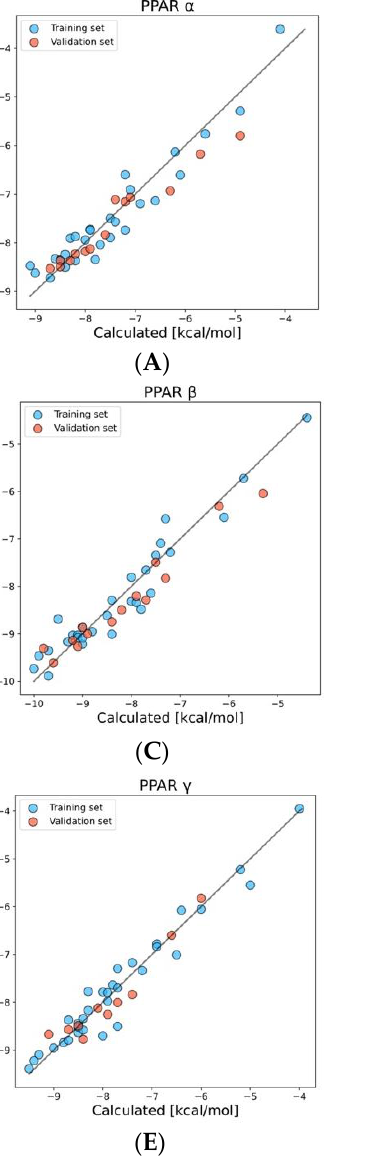
Figure 2. Plot of calculated versus predicted values of binding scores PPARα, β, and γ ( A ), ( C ), ( E ). Williams plot: dash line indicates the critical leverage value, solid lines represent ±3 standard deviation units ( B) , ( D) , ( F ).